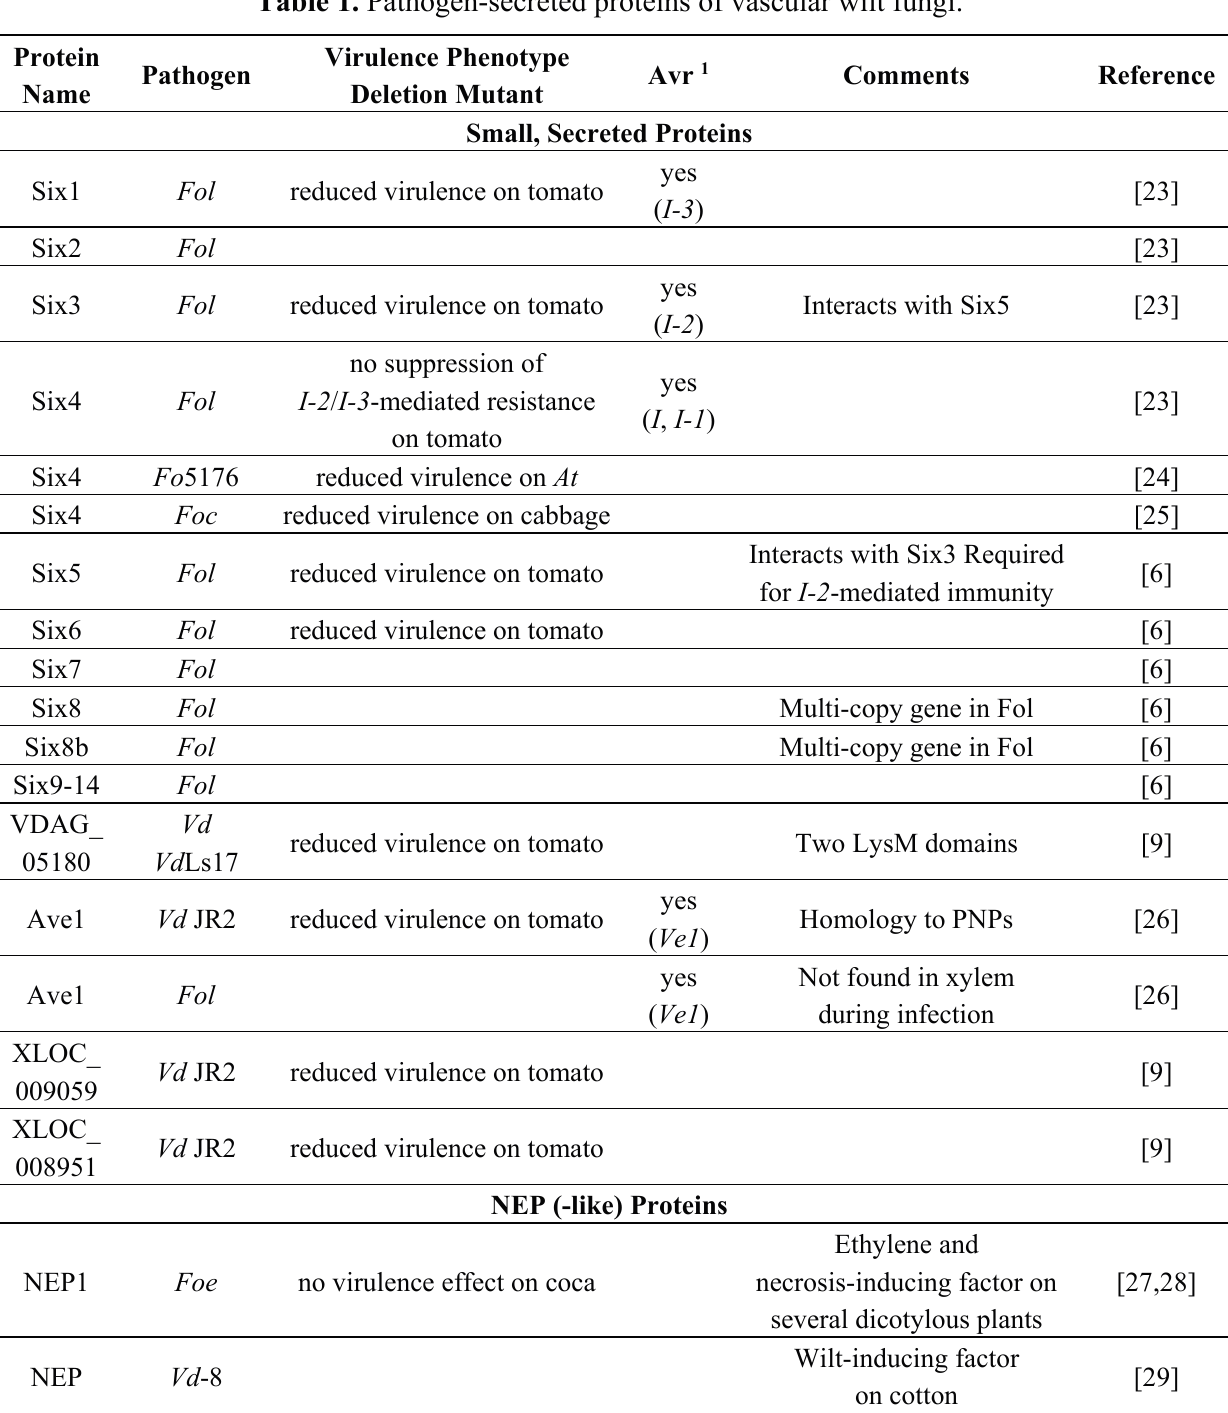
Table 1. Pathogen-secreted proteins of vascular wilt